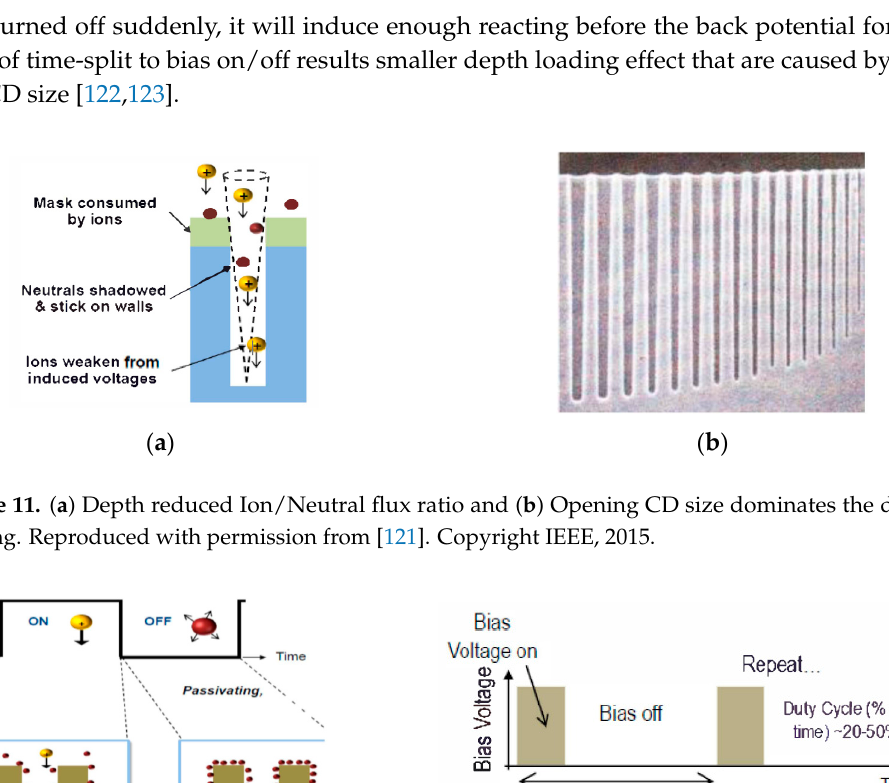
Figure 11. ( a ) Depth reduced Ion/Neutral flux ratio and ( b ) Opening CD size dominates the depth loading. Reproduced with permission from [121]. Copyright IEEE, 2015.